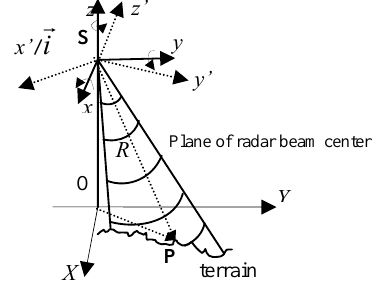
Fig 1. Range-coplanarity imaging geometry for side-looking